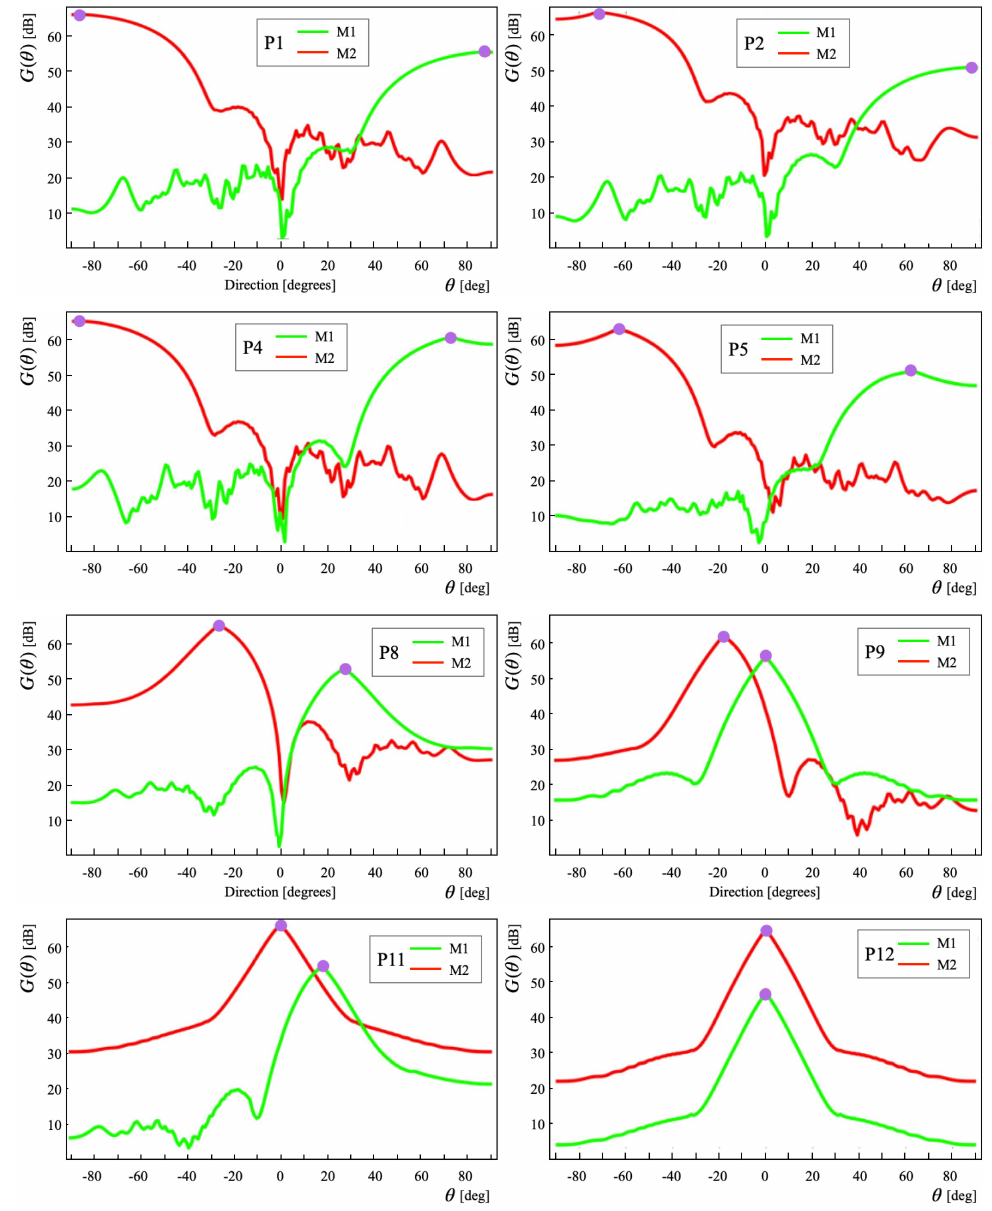
Figure 12. Angle estimation results obtained at eight positions (P1, P2, P4, P5, P8, P9, P11, and P12). Table 7 presents the experiment results: θ g 1 , θ g 2 , θ m 1 , θ m 2 , E 1 , and E 2 . The mean error values of M1 and M2 were, respectively, 1.25 ◦ and 0.92 ◦ . The highest error of M1 was 7 ◦ at P7. This error increased the mean M1